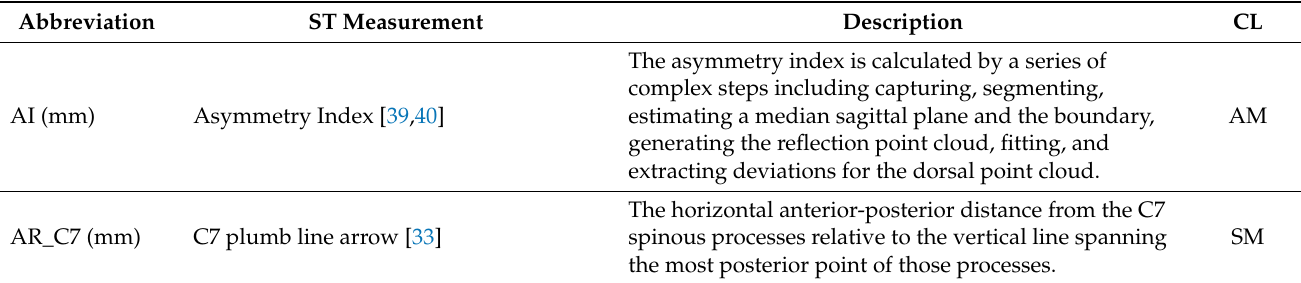
posterior shift; MAS = Maximum anterior shift; SR_AP = Anterior/posterior range; MR_CCW = Maximum CCW rotation; MR_CW = Maximum CW rotation; ROR = Rotation range; SRE = Smallest residual; LRE = Largest residual; RRE = Residual range; RLA_Min = Minimum right/left asymmetry; RLA_Max = Maximum right/left asymmetry; RLA_Ra = Right/left asymmetry range; TC = Thoracic curve; LC = Lumbar curve; T_IM = Trunk imbalance; T_IN = Trunk inclination; AI = asymmetry index; SD_amp = Side deviation-amp; SD_rms = Side deviation from symmetry line-rms; P_TI = Pelvis tilt; P_TO = Pelvis torsion; DAPI = Axial plane deformity index; POTSI = Posterior Trunk Symmetry Index; DCC = Maximum center Deviation; LTI = Lateral trunk inclination; FPT = Frontal pelvic tilt; STI = Forward-backward trunk inclination; BSR_max = Back surface rotation max; ATR_max = Axial trunk rotation max; TH = Trunk height; FAR = Frontal asymmetry ratio; FA = Frontal asymme- try; LAS = Lateral asymmetry; DHOPI = Axial plane deformity index; PC = Columnar Profile; 1 (Mean ± SD). 2 (Mean ± SD OP1 , Mean ± SD OP2 ).